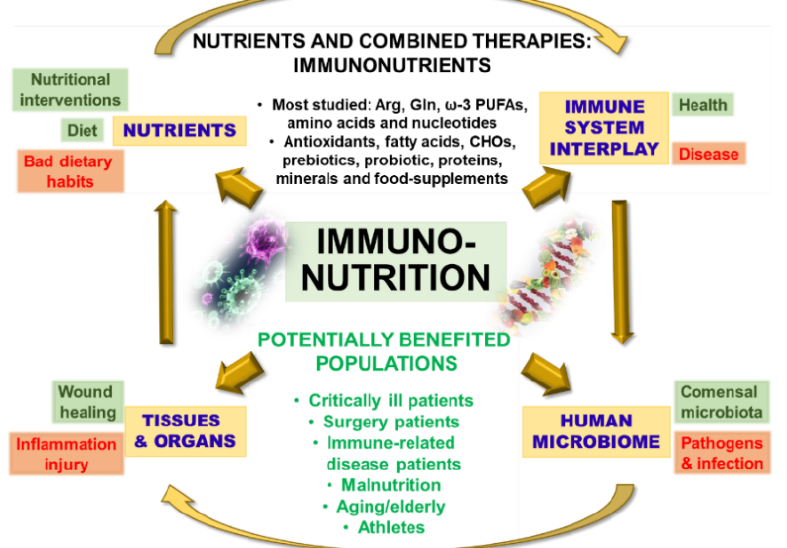
Figure 1. Immunonutrition overview. Basic pillars of immune-modulating nutrition. The term immunonutrition is mainly powered by four interconnected concepts: immune system, nutrition, body organ metabolism, and the human microbiome. These relationships pave the way for a wide and complex multidisciplinary topic with potential applications. The immune system comprises an intricate network of mechanisms, signals, cells, organs, and tissues. It is extraordinarily variable between subjects and when it fails, it can shift the fine line between health and disease. Bad dietary habits can lead to the poor nutritional status of the subject and consequently to severe pathologies. Nutritional interventions are needed at this point. Single nutrients or combined therapies, all of them designated as immunonutrients, are considered key tools. The most studied are arginine (Arg), glutamine (Gln), n-3 fatty acids (ω-3 PUFAs), amino acids, and nucleotides. Antioxidants, fatty acids, carbohydrates (CHO), prebiotics, probiotics, proteins, minerals, and food supplements are other employed immunonutrients. Deficiency of certain nutrients leads to compromised immunity and a high predisposition to infections. The immune system fights against harmful agents such as bacterial antigens supported by its ability to distinguish between self and nonself molecules. This includes foreign components and commensal microbiota. After infection, innate and adaptive immune responses occur, generally through inflammatory processes and metabolic changes. These events can trigger tissue injury, as well as undernutrition or malnutrition. An inadequate intake of macro- and micronutrients negatively affects the immune system. Nutrients help repair tissues (wound healing), modulate cytokine release, or protect organs from free radicals or oxidants. Immunonutrition provides potential benefits to varied and numerous populations: from critically ill patients to professional athletes, and including patients undergoing surgery, subjects with immuno-related diseases, people at potential risk of malnutrition, or the elderly.